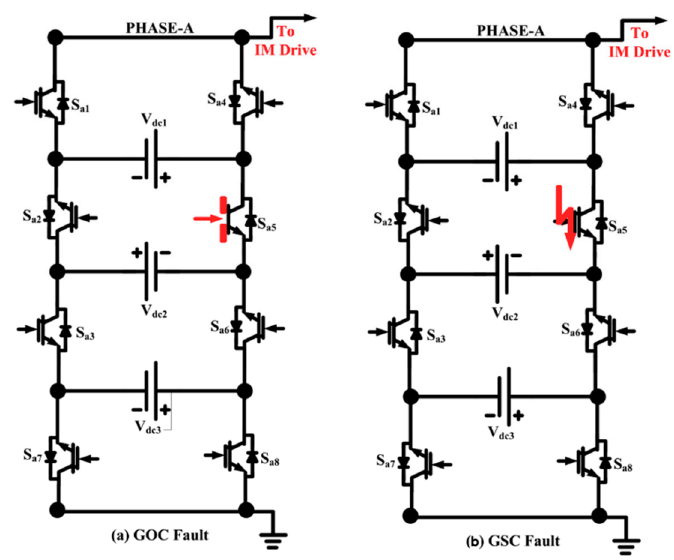
Figure 3. ( a ) Gate-open and ( b ) gate-short circuit fault